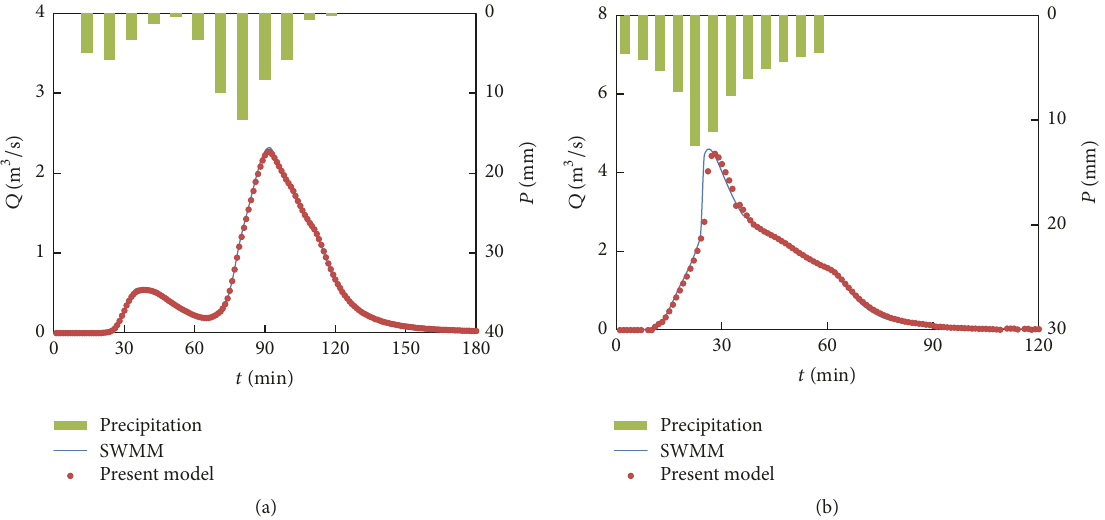
Figure 8: History of discharge change process at downstream outfall: (a) R1; (b)